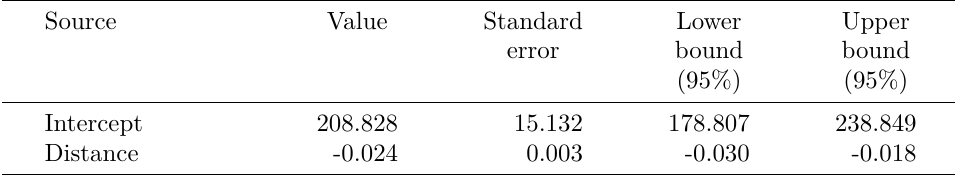
Table 2: General estimation results (Model